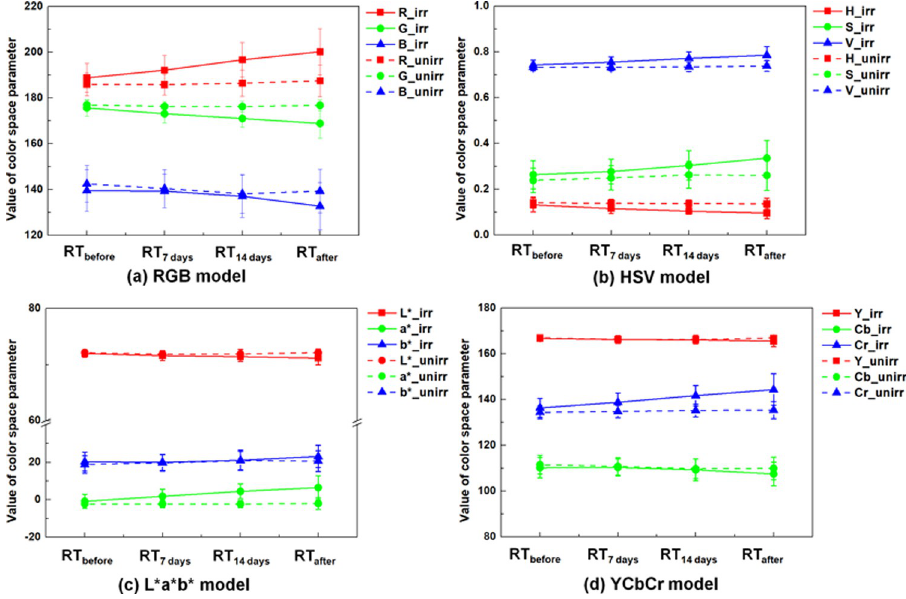
Fig 2. Mean and standard deviation of parameters for (a) RGB, (b) HSV, (c) L � a � b � , and (d) YCbCr color space models over time. “irr” and “unirr” denote the parameters for irradiated and unirradiated breasts,